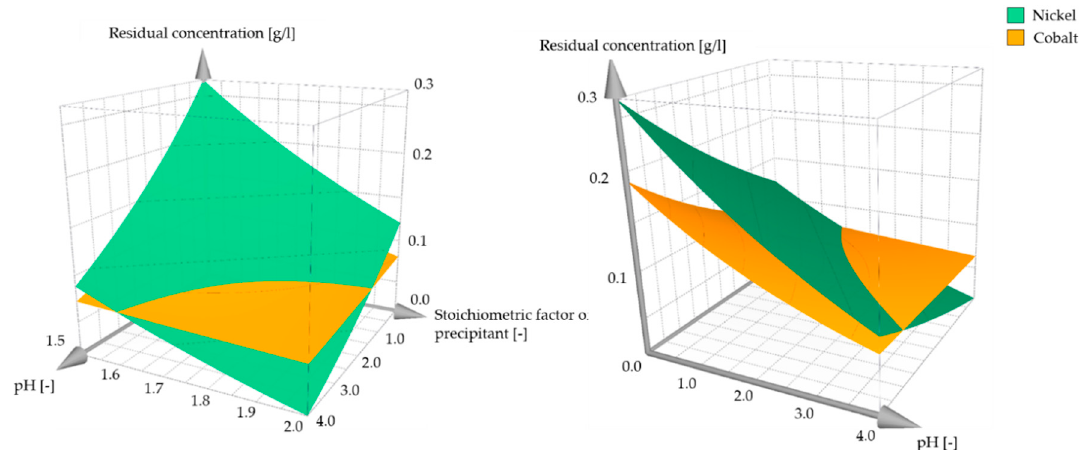
Figure 14. Surface plots for cobalt and nickel precipitation as oxalates and their dependency on the pH value and the stoichiometric factor of oxalic acid addition.